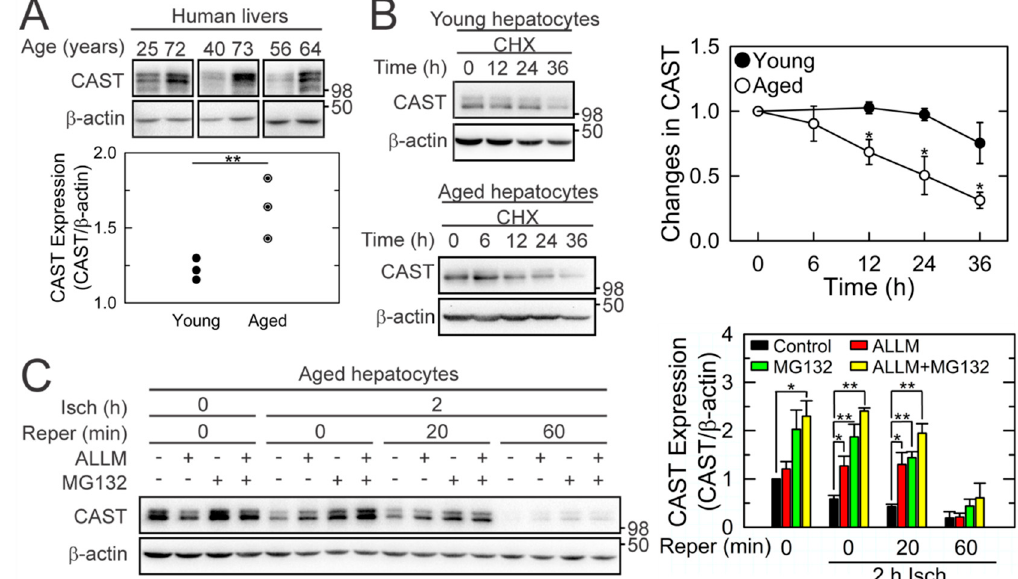
Figure 2. Decreased protein stability of CAST in aged livers. ( A ) CAST expression in human livers at different ages before the commencement of ischemia ( n = 6). ( B ) Alterations of CAST expression in young and aged mouse hepatocytes in the presence of 35 μ M CHX ( n = 5). ( C ) Effects of 10 μ M ALLM (calpain inhibitor) and 50 μ M MG132 (proteasome inhibitor) on CAST expression in aged hepatocytes during I/R ( n = 3). * p < 0.05 and ** p < 0.01.